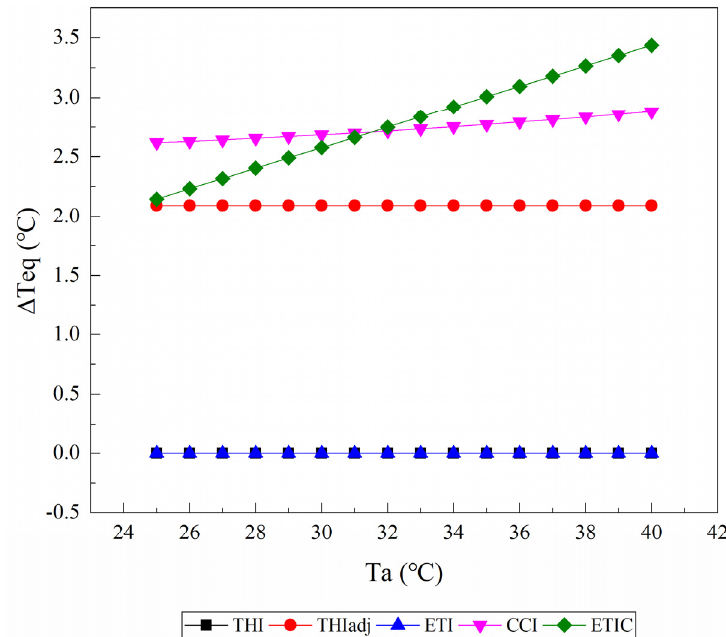
Figure 5. The changes of the equivalent ambient temperature change ( Δ Teq) caused by an increase in solar radiation from 100 W/m 2 to 500 W/m 2 as air temperature (Ta) rises from 25 to 40 °C are reported from the temperature–humidity index (THI), adjusted THI (THIadj), equivalent temperature index (ETI), comprehensive climate index (CCI), and equivalent temperature index for dairy cattle (ETIC). Relative humidity is assumed to be 50%, and wind speed is assumed to be 0.2 m/s. THI2, THI3, and black globe humidity index (BGHI) are not included since they do not contain solar radiation and relative humidity.